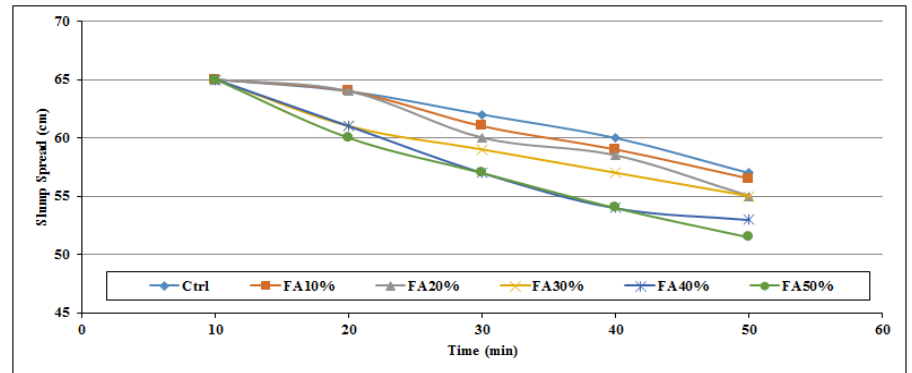
Figure 5. Slump loss diagram for FA powder samples throughout the first 50 min.